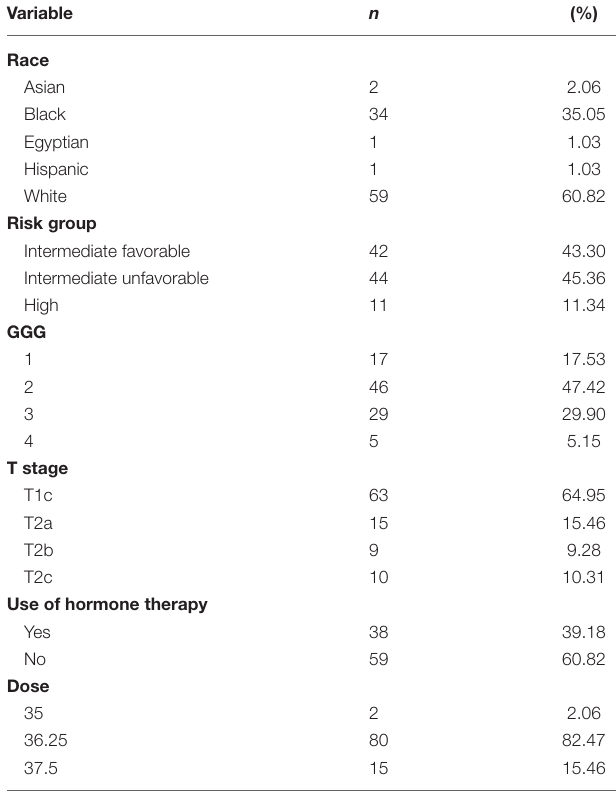
TABLE 2 | Descriptive statistics for categorical